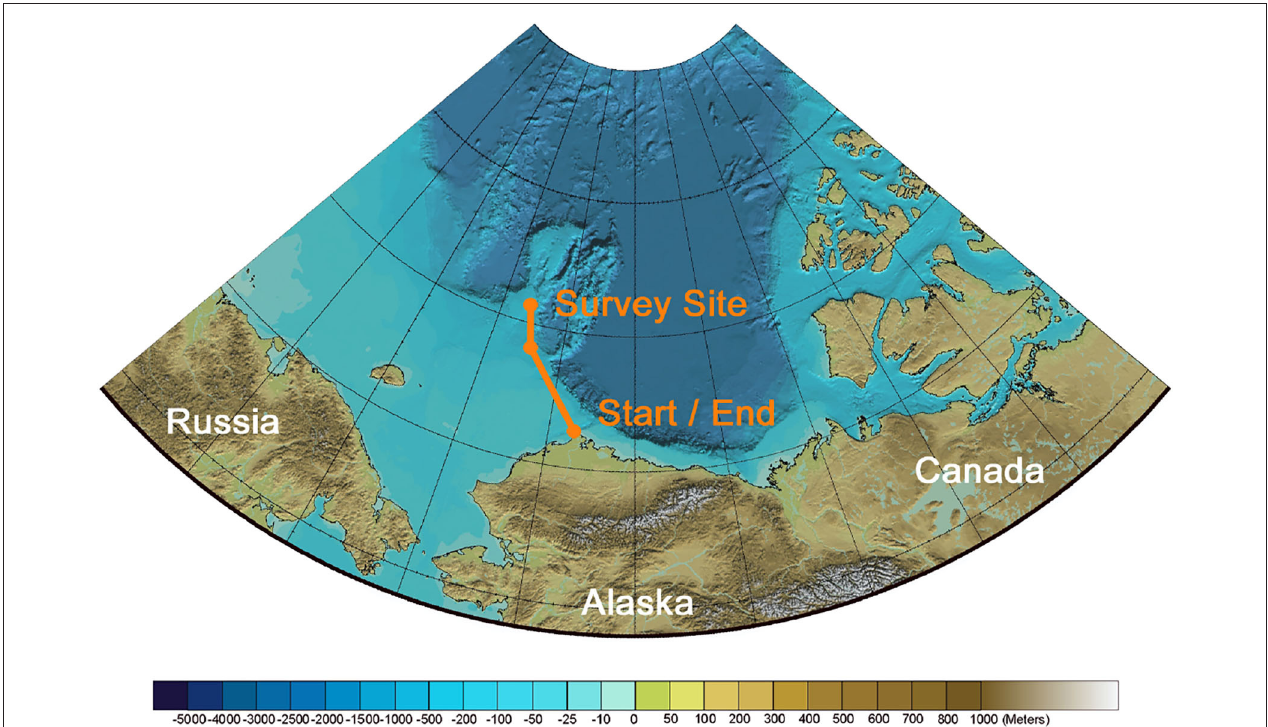
FIGURE 12 | Overview of unattended glider sea-ice survey mission scenario during the spring-summer sea-ice retreat. For this mission, the glider departs Utqia ˙ gvik, Alaska, transits 456km to the survey site on the Chukchi Plateau, performs a sea-ice survey, and then transits 456km back to Utqia ˙ gvik. The feasibility of this mission depends on the resource management of the glider. Figure adapted from bathymetric map by Jakobsson et al.